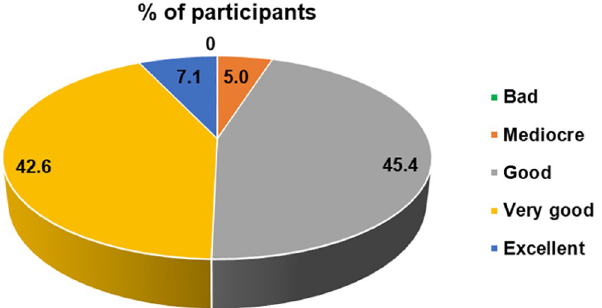
Fig 2. User satisfaction regarding the use of COVID-PRESTO 1 as a self-test. Percentages of participants for each choice of response to the question no.7 of the satisfaction questionnaire.